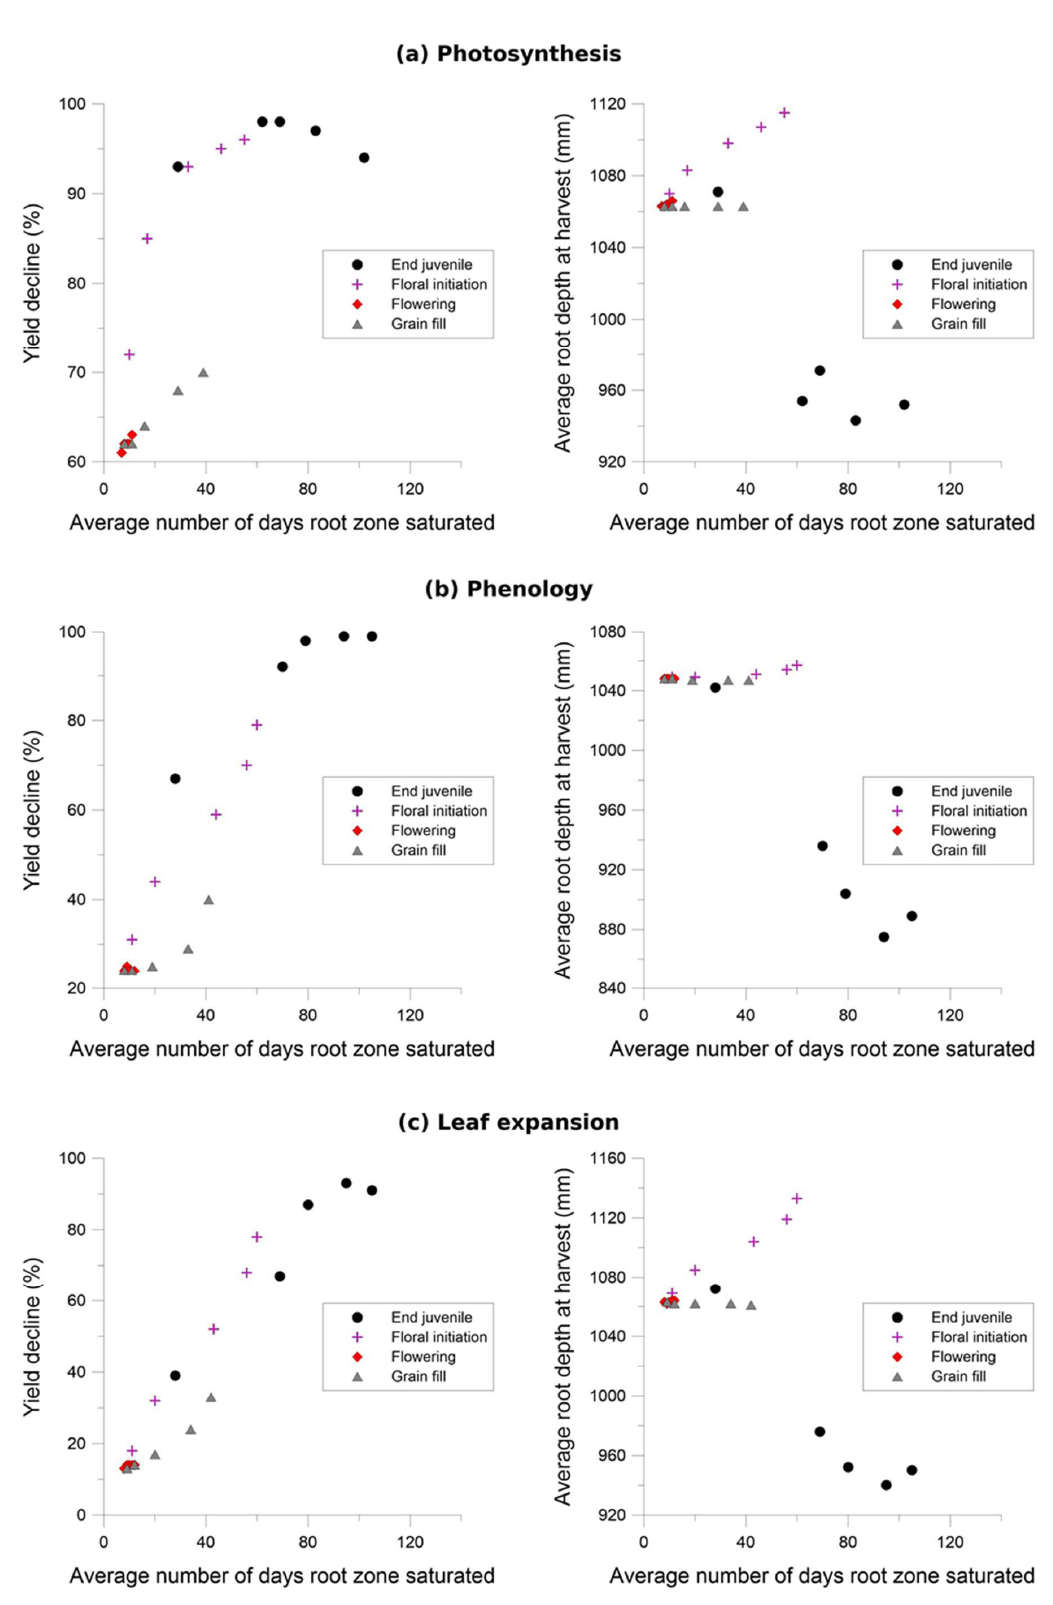
Figure 6. The impact of three waterlogging functions: ( a ) photosynthesis, ( b ) phenology and ( c ) leaf expansion, on yield and root depth.